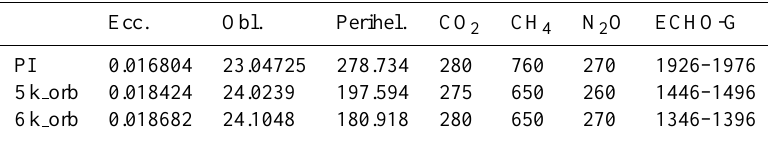
Table 1. Orbital (eccentricity, obliquity, perihelion) and greenhouse gas (CO 2 , CH 4 , N 2 O) forcing of the three periods investigated. Boundary conditions were derived from a transient simulation with the AOGCM ECHO-G (Lorenz and Lohmann, 2004). The used specific model years from this experiment are given in the last column. Ecc. Obl.